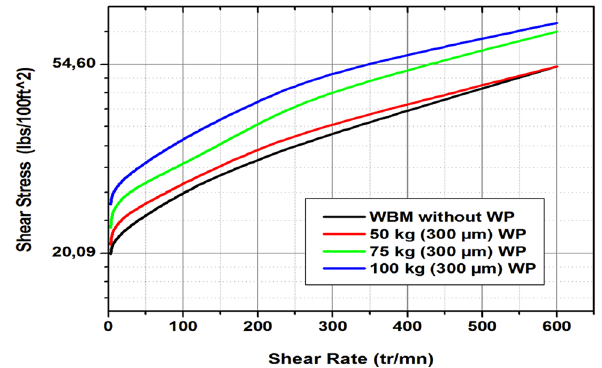
Fig. 4 PAC_ul and CMC substituted by wood powder (WP at size = 300 µm) at different contents